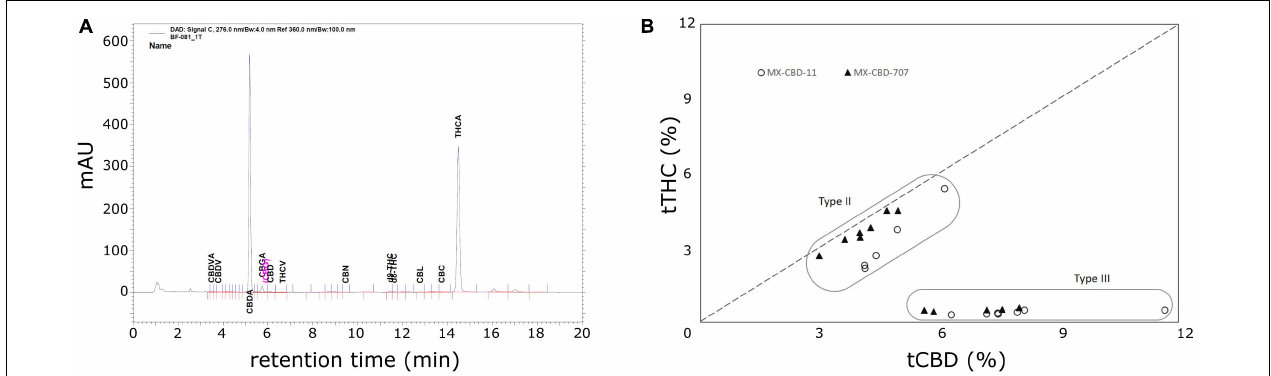
FIGURE 2 | The results of high-performance liquid chromatography (HPLC) analysis of dried inflorescences of breeding populations MX-CBD-11 and MX-CBD-707: (A) A representative HPLC chromatogram showing the retention times of various cannabinoids from MX-CBD-707/plant 41; (B) total cannabidiol (tCBD) and total tetrahydrocannabinol (tTHC) contents (in % w/w) in all 24 analysed cannabis plants. Each dot represents the measurements of one inflorescence per plant.